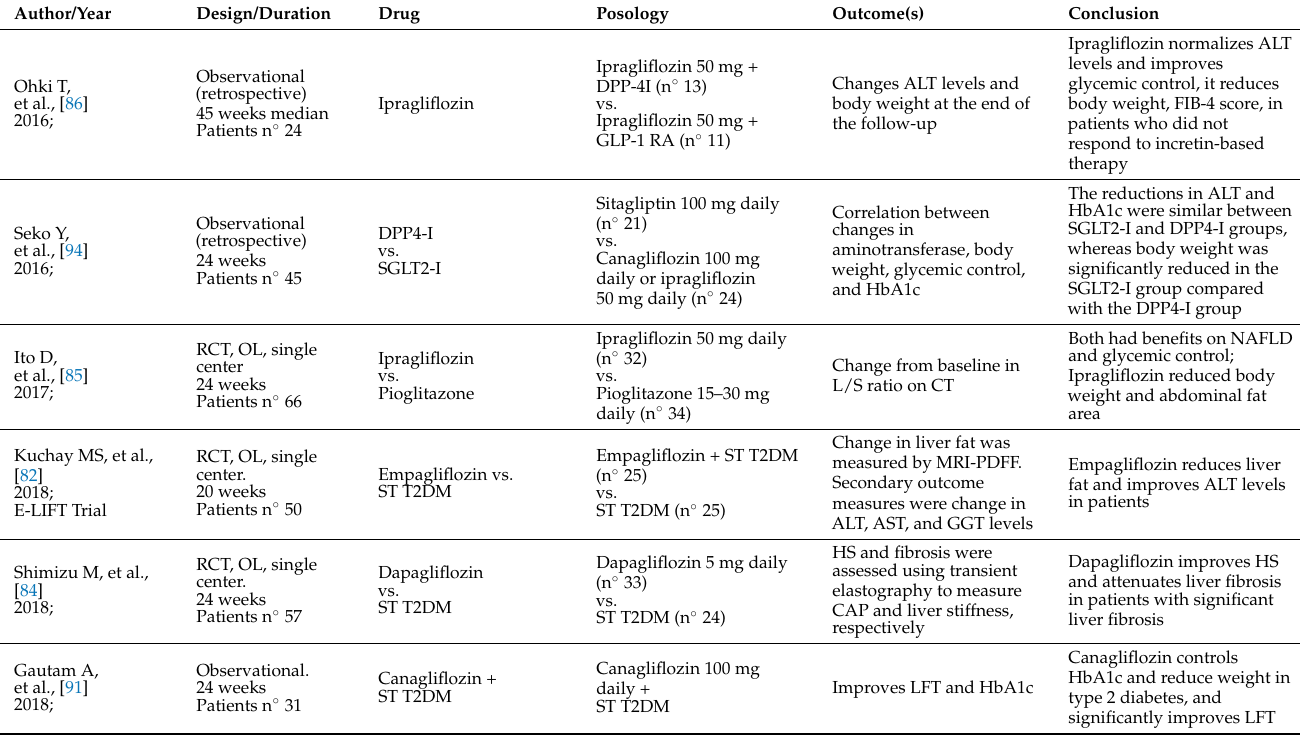
Table 1. Features of the studies published on SGLT2-I effects on NAFLD